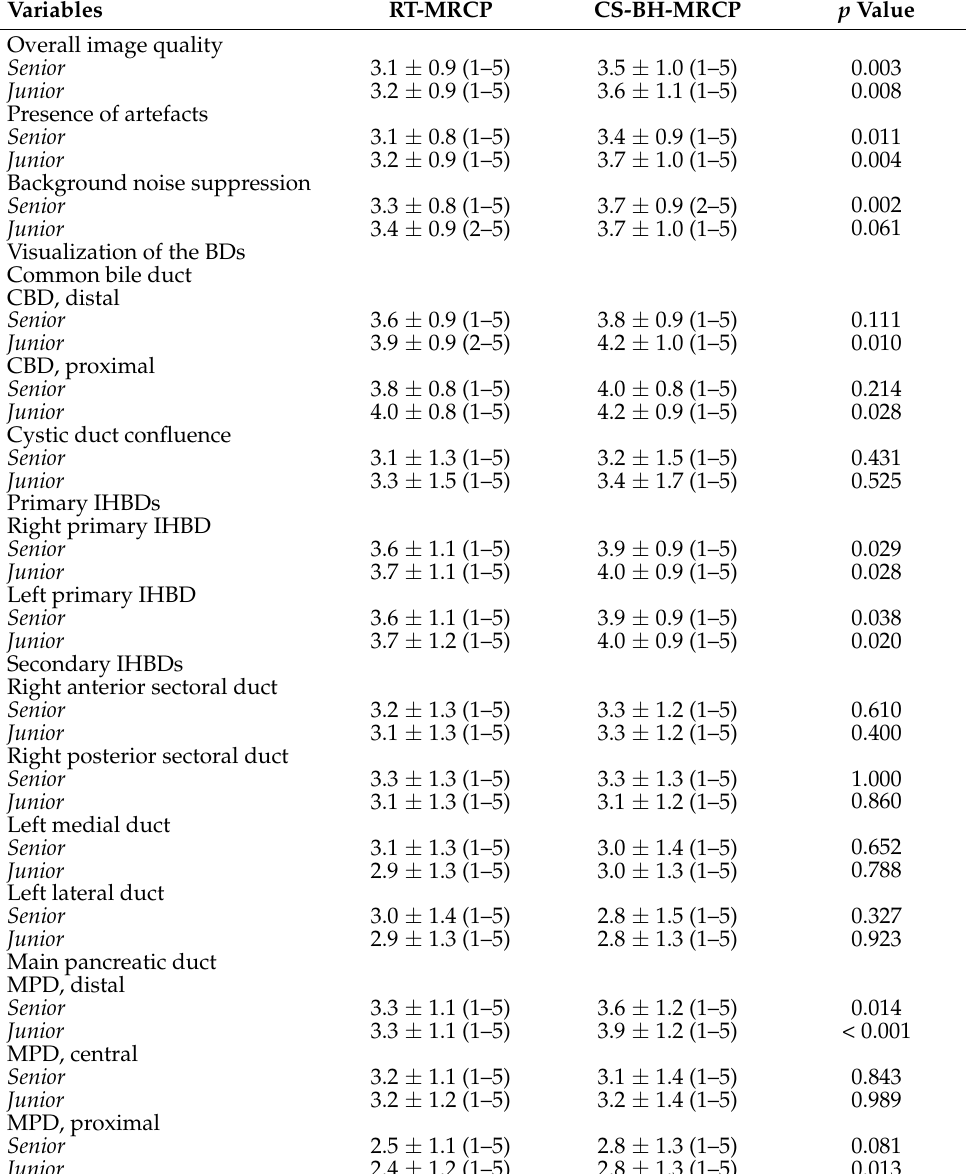
Table A2. Qualitative evaluation: Comparison of the two sequences RT-MRCP and CS-BH-MRCP: mean value ± SD (range) of each qualitative variable based a 5-point Likert scale, obtained by each of the two readers (senior and junior